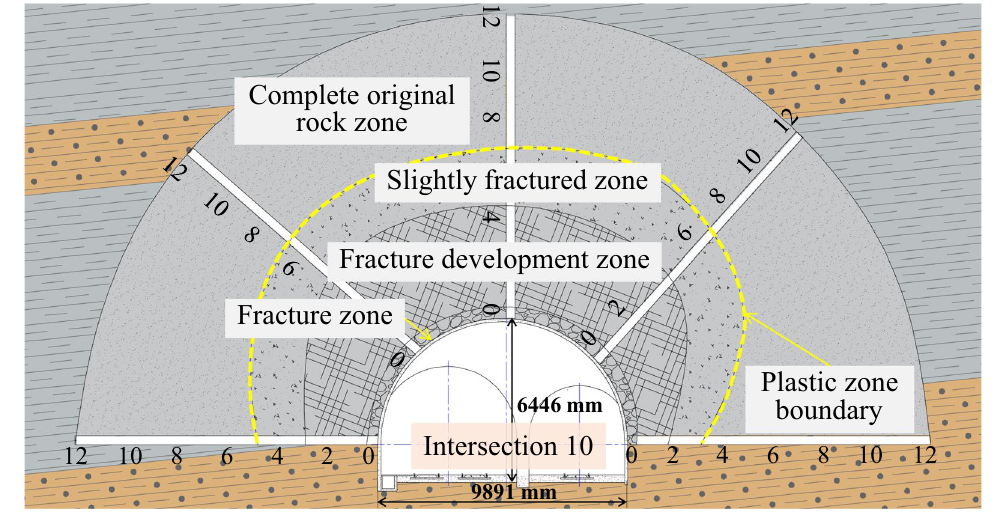
Fig. 5 Schematic of borehole-scoping and zoning failure of the surrounding rock